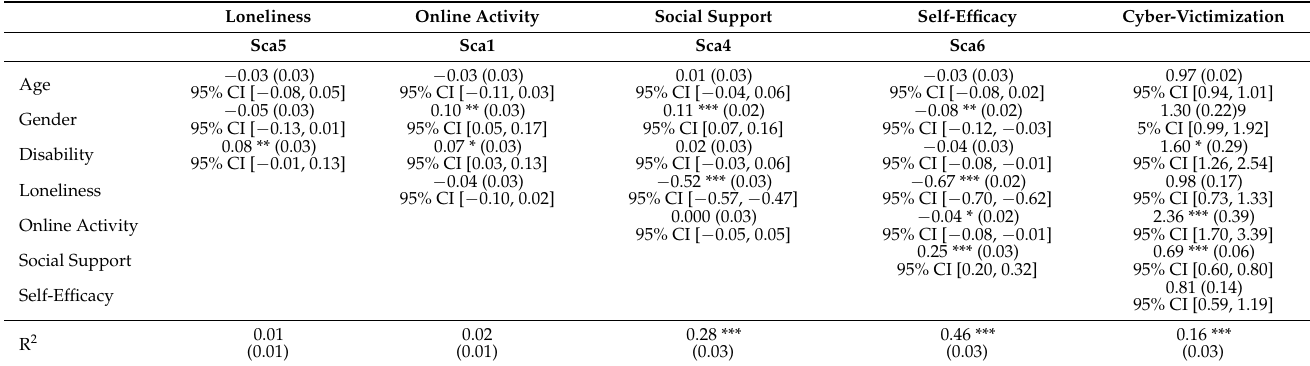
Figure 2. Path Analysis results for the probability of experiencing cyber-victimization. Note. *** p < 0.001, ** p < 0.01, * p < 0.05; Straight one head arrow for regression path, double-arrow arch for correlation. Table 2. Modeling results, standardized regression coefficients and